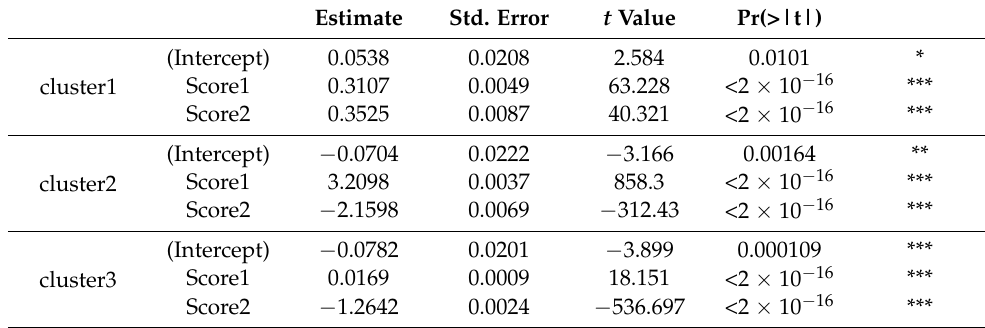
Table 4. Regression Results based on the FCR-HL Model. Estimate Std. Error t Value Pr(>|t|) (Intercept) cluster1